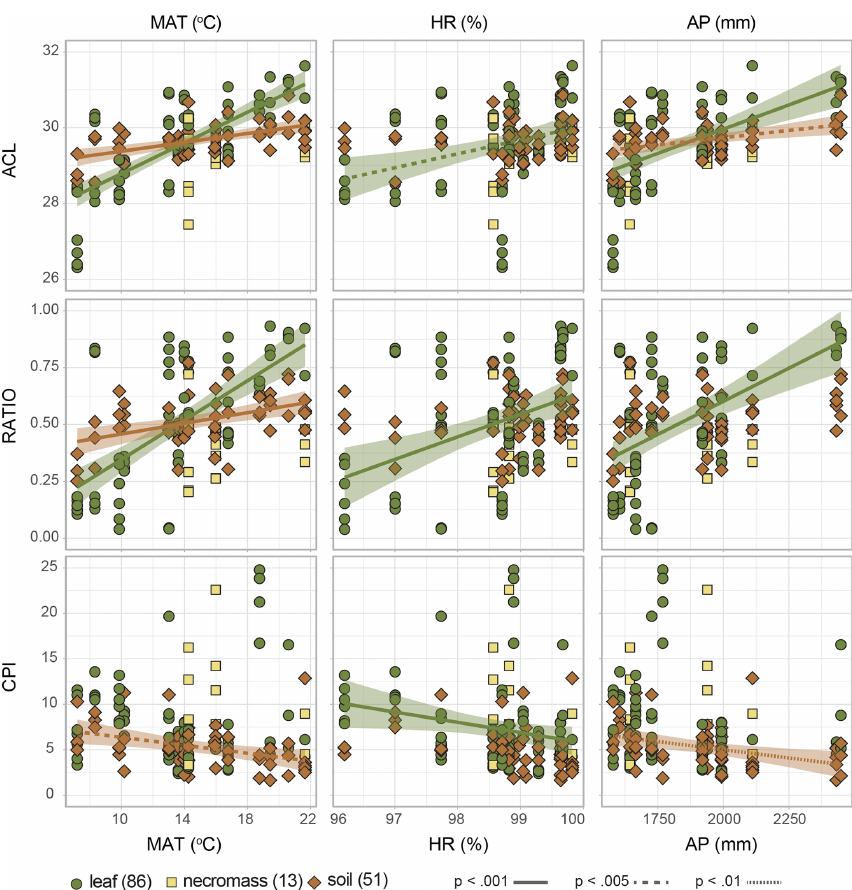
Figure 5. Scatterplots of n -alkane metrics (ACL = average chain length, RATIO = C 31 / (C 31 + C 29 ), CPI = carbon preference index) along the environmental gradient (MAT = temperature, HR = humidity, AP = precipitation). Symbols and colours indicate sample type (green circles = leaf, yellow squares = necromass, brown diamonds = soil), numbers in parentheses represent number of samples. Shading indicates the standard error of the linear correlation (lines), line type represents the significance level of the correlation. Represented correlation coefficients and p values correspond to values in Fig. 4 and Table